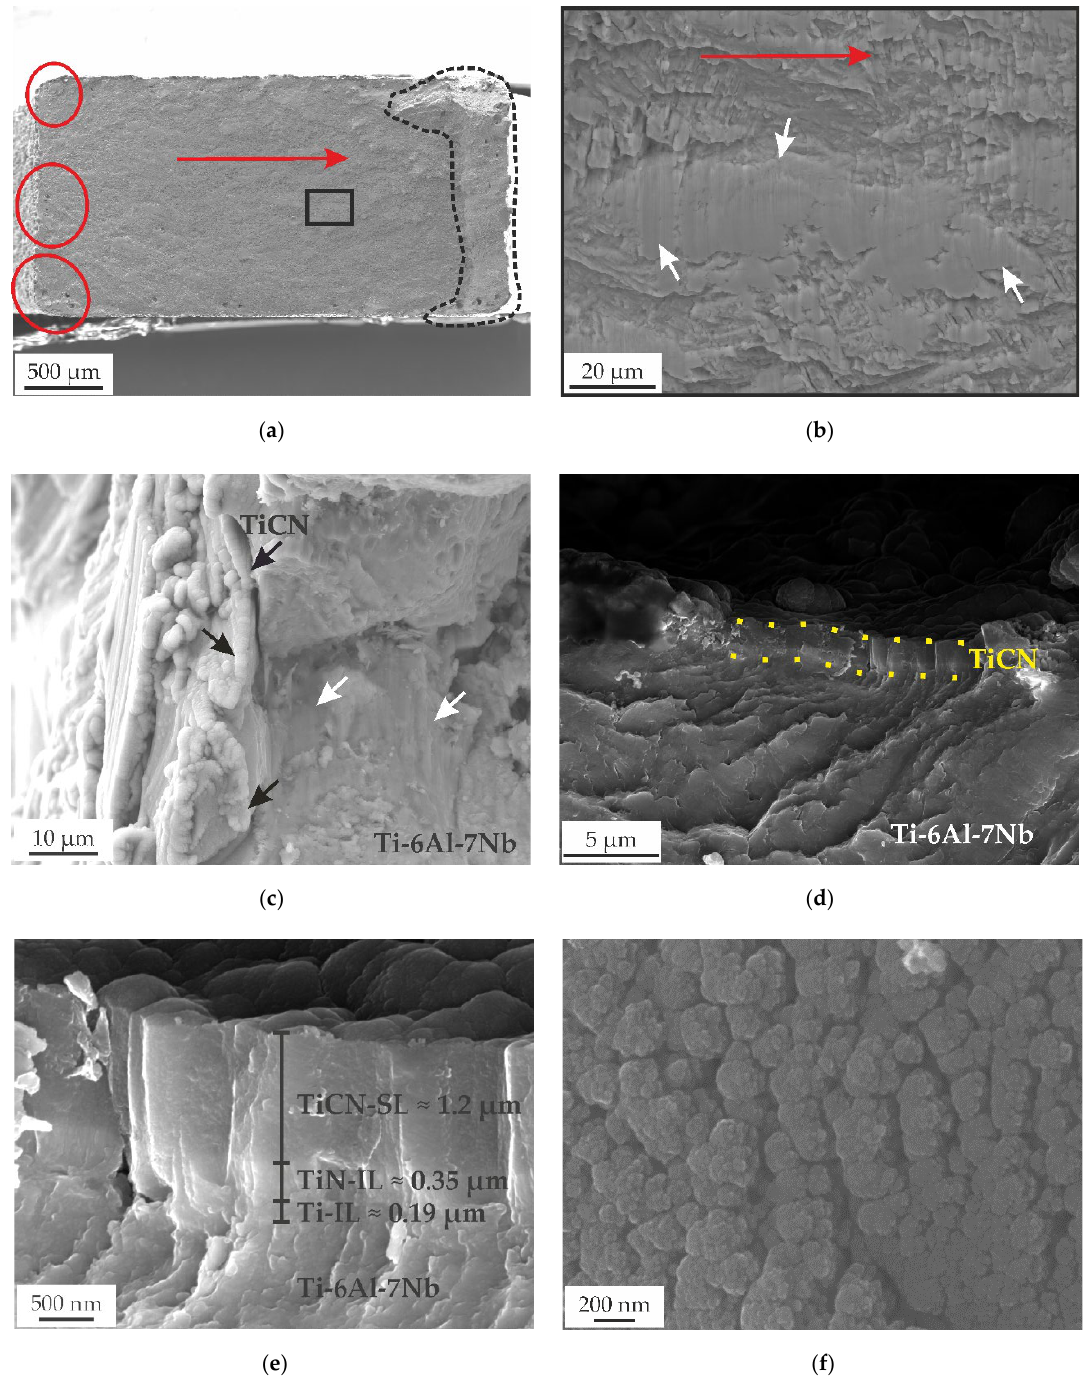
Figure 5. SEM images of the fracture surface of a TiCN-coated specimen; ( a ) overview SE image of the fracture surface, forced fracture surface indicated with the dashed line, possible crack nucleation sites within the red circles, the red arrow indicates crack propagation direction; ( b ) fracture surface from the black square in ( a ), with crack propagation direction (red arrow) and fatigue striations (white arrows); ( c ) TiCN coating (black arrows) on the substrate material (right area) and fatigue striations on the fracture surface (white arrows); ( d ) in-lens image of the TiCN coating (yellow dashed lines) in the edge region of the fatigue fracture surface of the substrate (bottom area); ( e ) in-lens image of TiCN surface layer (TiCN- SL), TiN interlayer (TiN-IL), and Ti interlayer (Ti-IL) at the edge of a fractured surface (bottom area) after fatigue testing; ( f ) TiCN surface with cauliflower-like structure.